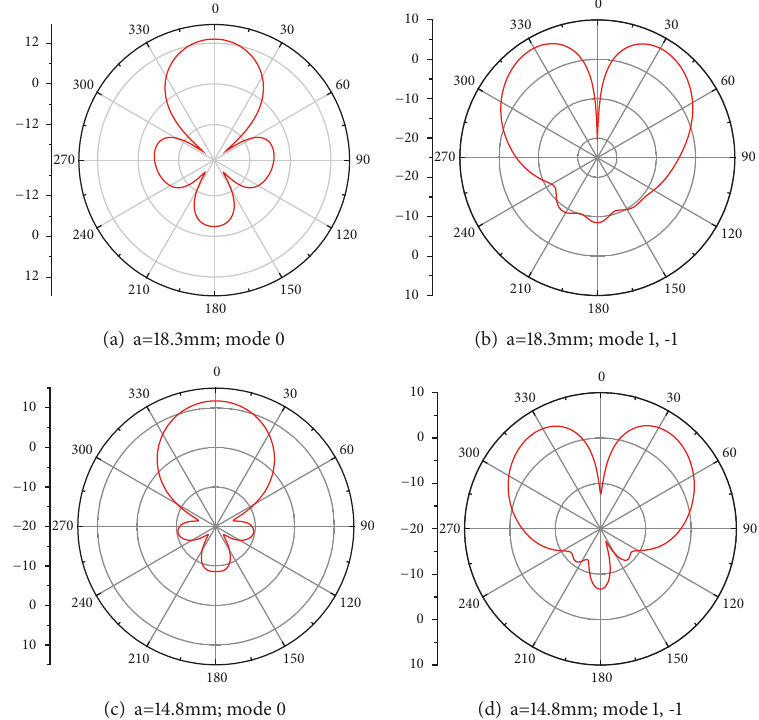
Figure 6: Simulated patterns of generator with different radiuses of array.